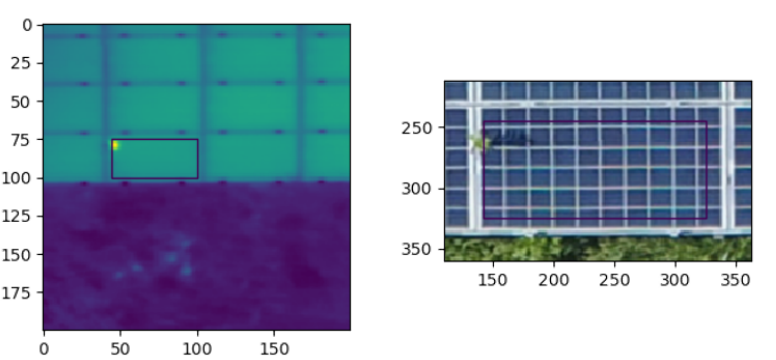
Figure 3. Hotspot in a thermal image ( left ) caused by overgrown vegetation visible in the RGB image ( right ). While thermal images can be used to easily detect hotspots, they do not provide information on the root cause of the anomaly. The RGB image can help to determine the latter anomaly: in case a peculiarity is visible, the hotspot may be caused by an external factor, whereas in the other case the cause is probably physical, indicating a more severe underlying